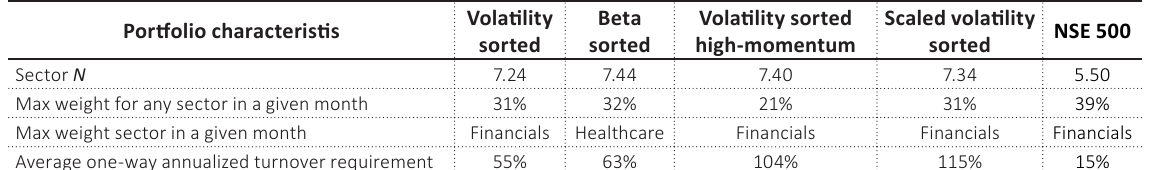
Table 6. Sector exposure statistics and one-way turnover for low - risk investment strategies